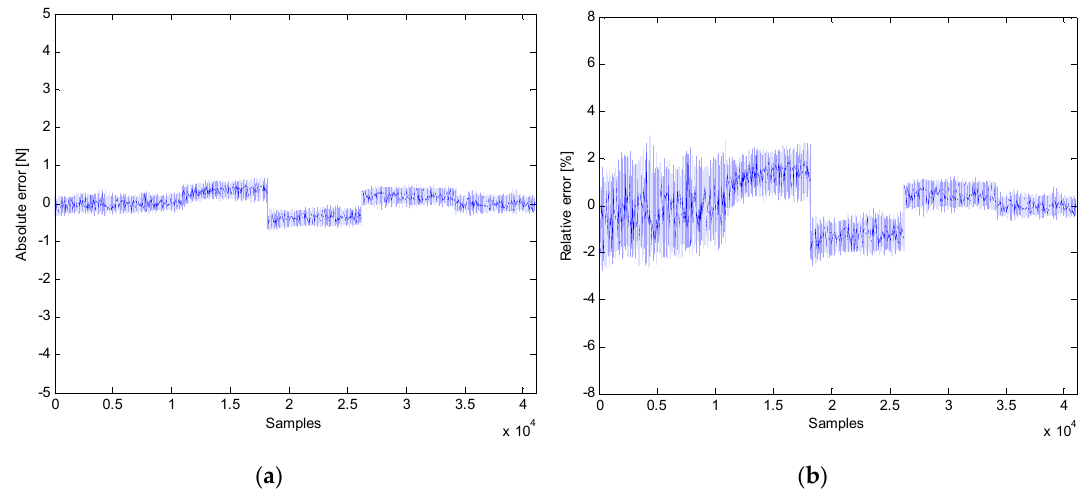
Figure 9. Force measurement errors: ( a ) Absolute error; ( b ) Relative error.